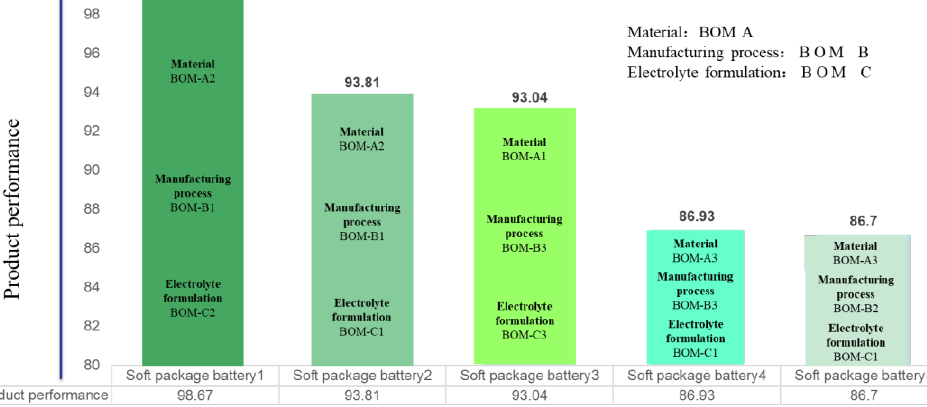
Figure 16. Relationship between product performance and process